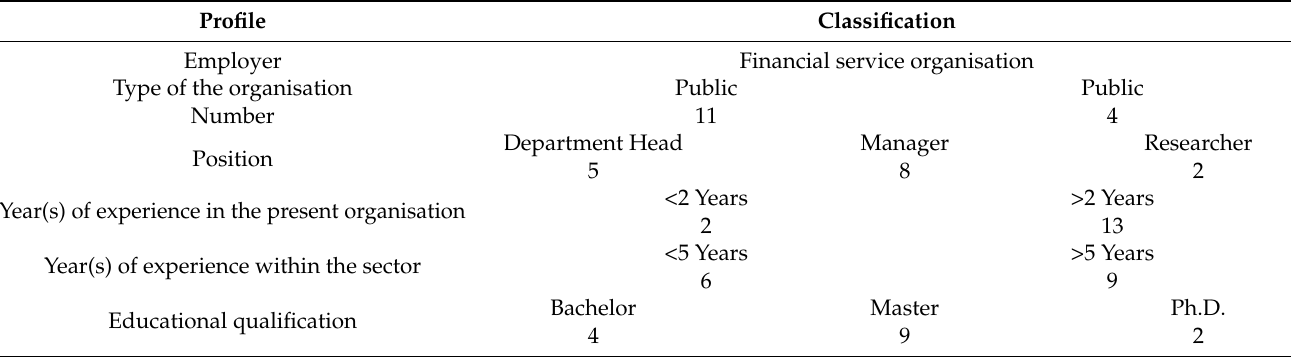
Table 3. Profile of experts.